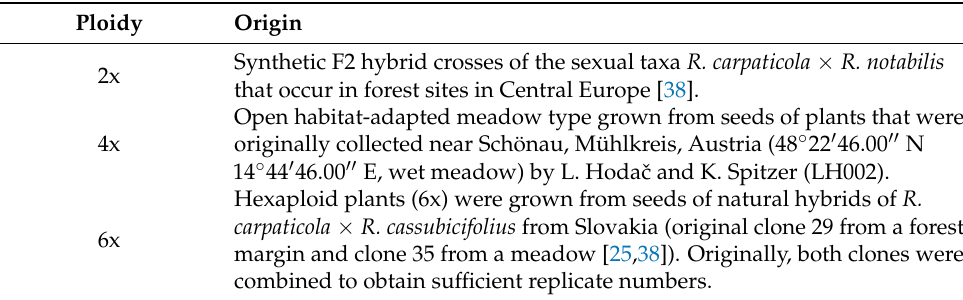
Table 1. Origin of 2x, 4x, and 6x Ranunculus auricomus plants. Ploidy